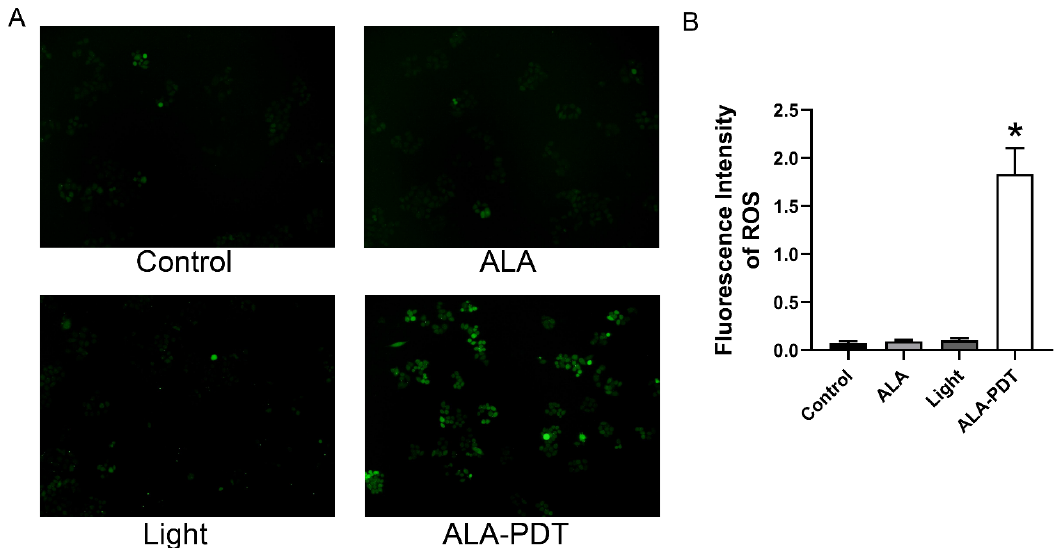
Figure 3. The effect of ALA-PDT on ROS production in HeLa cells. ( A ) The green fluorescence of ROS (100 × ). ( B ) Statistical analysis of the fluorescence intensity of ROS. * p < 0.05 compared with the control group.